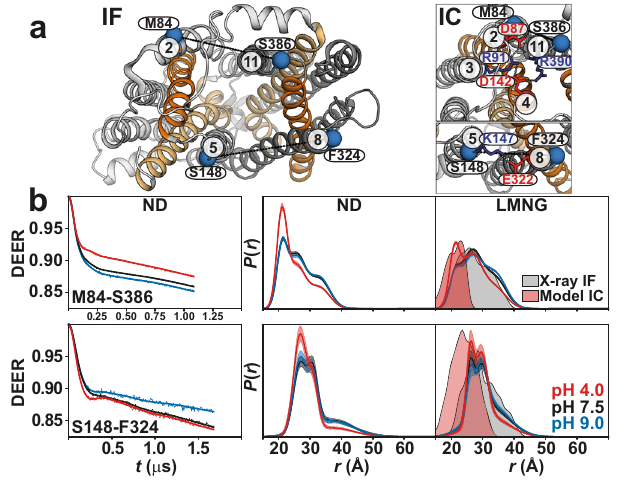
Fig. 2 | Protonbinding closestheintracellular side of Hn Spns.a Spin label pairs (bluespheres)forDEERdistancemeasurementofthegatinghelicesacrosstheNTD and CTD on the intracellular side of the IF crystal structure and the intracellular- closed (IC) model. b Raw DEER decays and fi ts (left) are presented for the experimentally-determined distributions P ( r ) in nanodiscs (middle) and LMNG micelles (right) fortwo distancepairs, M84-S386and S148-F324(dotted linesin a ), under acidic, neutral, and basic pH conditions. Con fi dence bands (2 σ ) are shown about the best fi t lines. This band, which depicts the estimated uncertainty in P ( r ), re fl ects the error associated with the fi tting of the primary DEER trace. The dis- tributionspredictedfromtheIFcrystalstructureandtheICmodelareshadedgray and red,